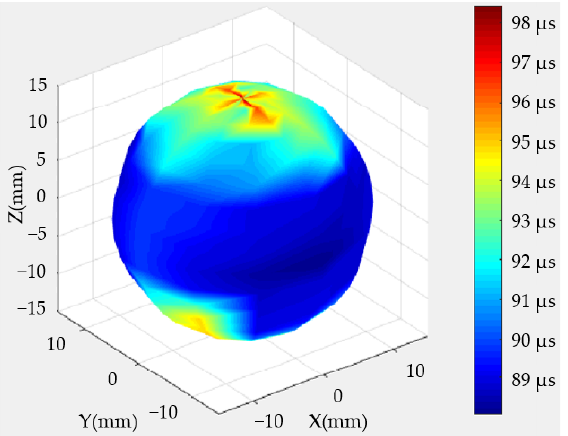
Figure 7. Arrival times of shear waves on the basis of scanning-measurement endings.